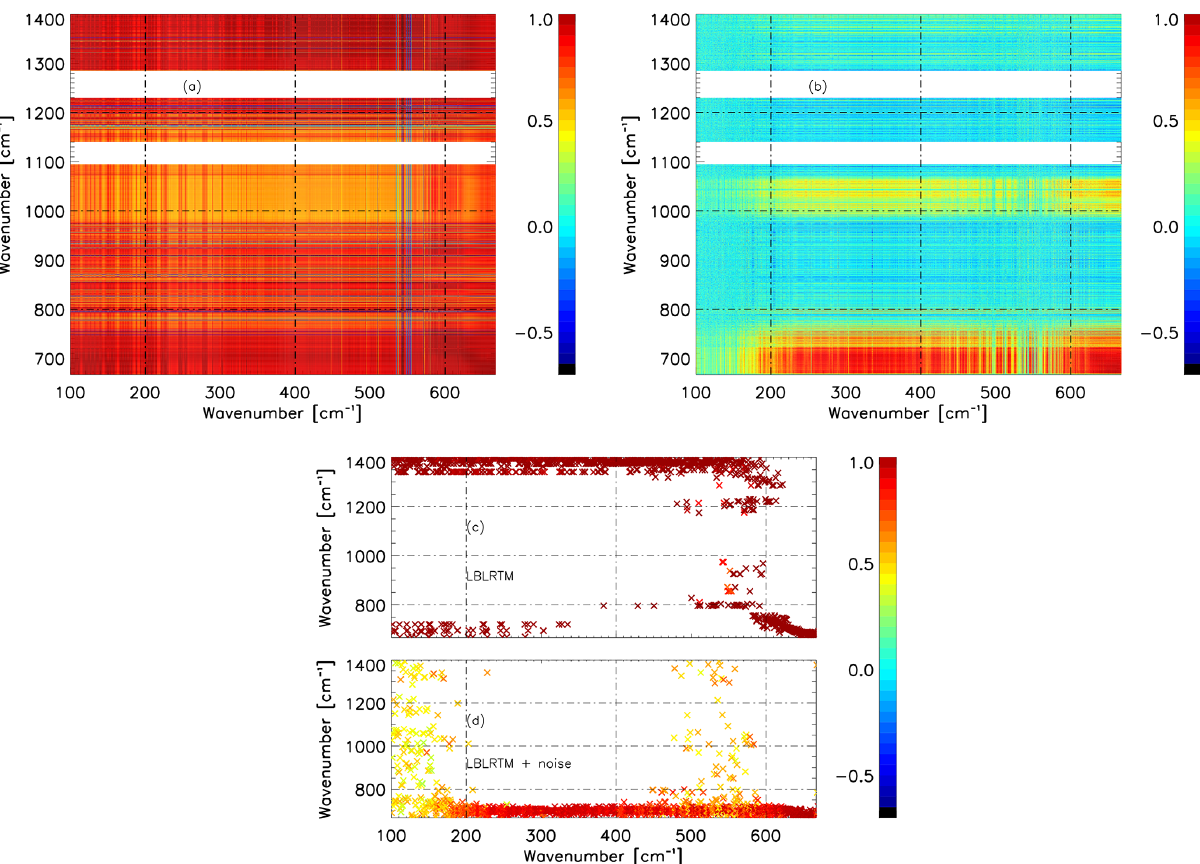
Figure 5. Correlation map using noiseless LBLRTM spectra (a) and LBLRTM spectra with realistic noise added (b) . Panels (c) and (d) are as Fig. 2b, showing predictor wavenumbers for LBLRTM without noise and with noise